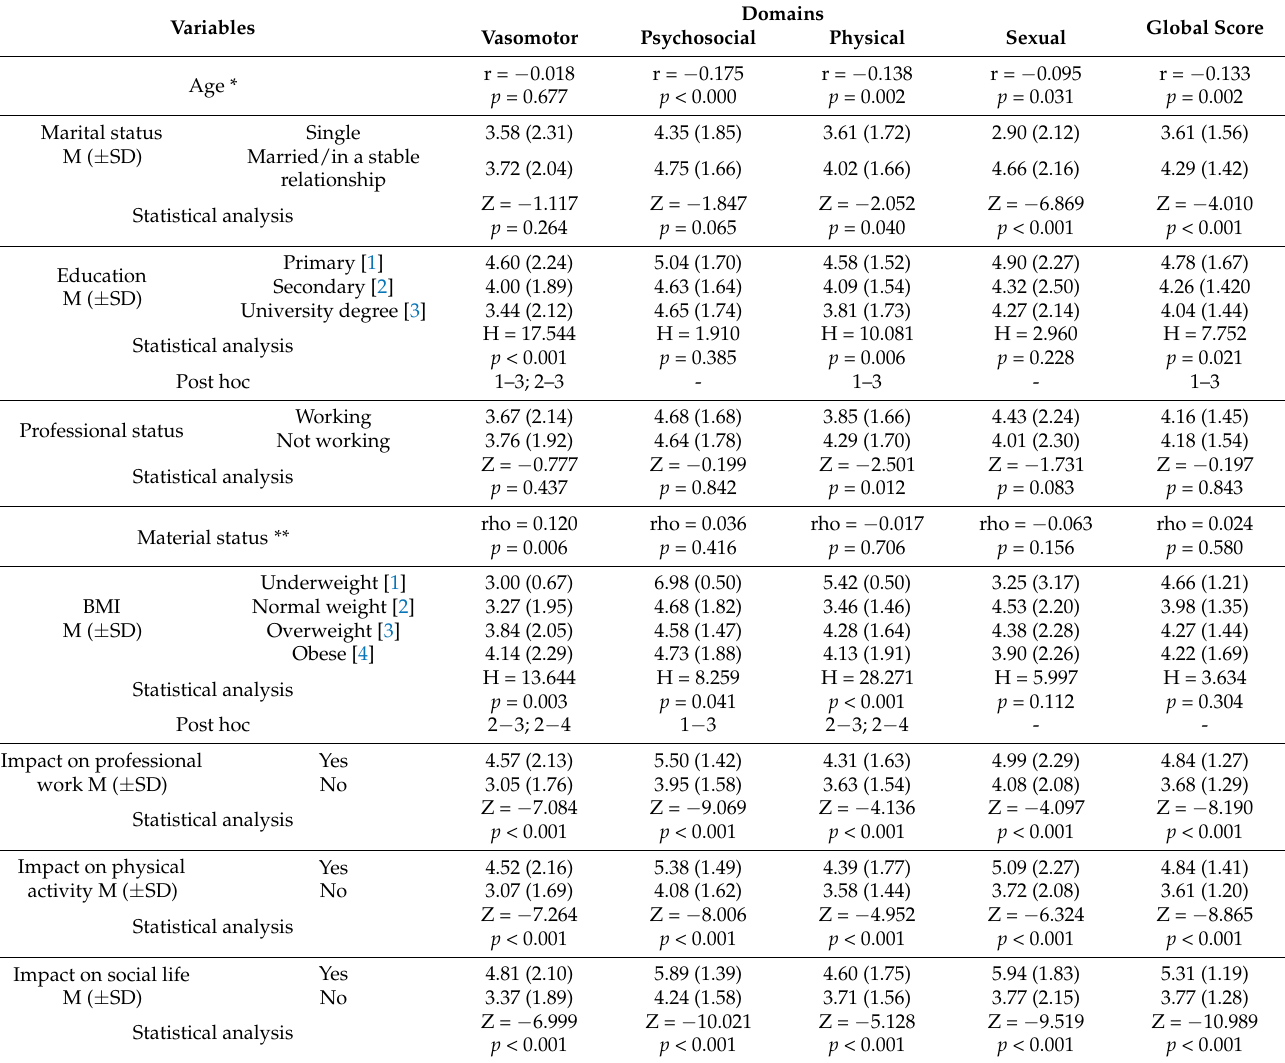
Table 6. Sociodemographic variables and quality of life in menopausal